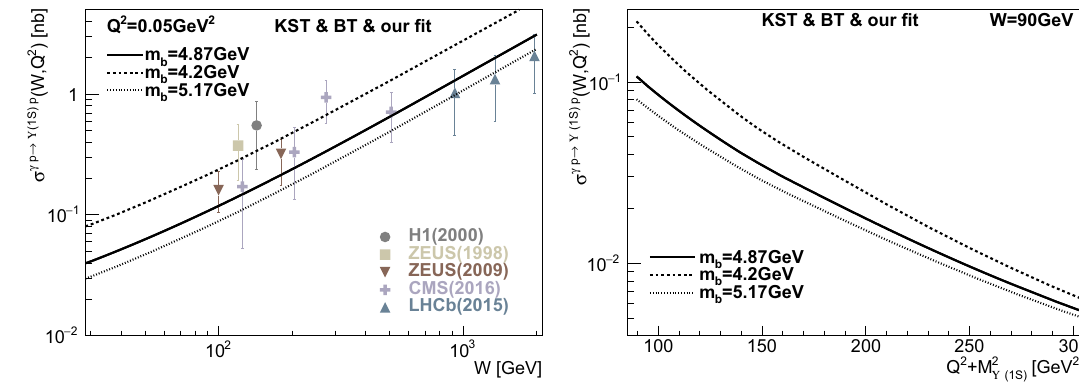
Fig. 18 The same as the left panel of Fig. 8 but for the test of sensitivity of the model predictions to the bottom quark mass m b The sensitivity of model predictions to quark mass